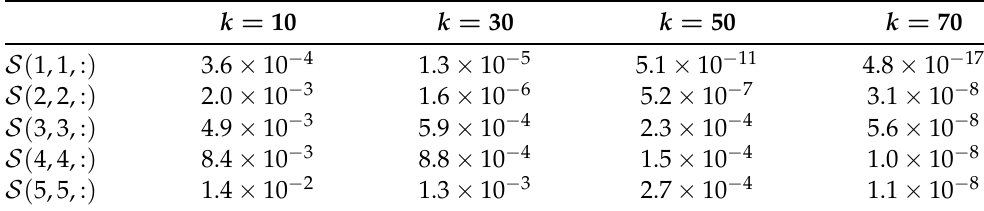
Table 1. (cid:107)S ( i , i , : ) − Σ ( i , i , : ) (cid:107) F vs k